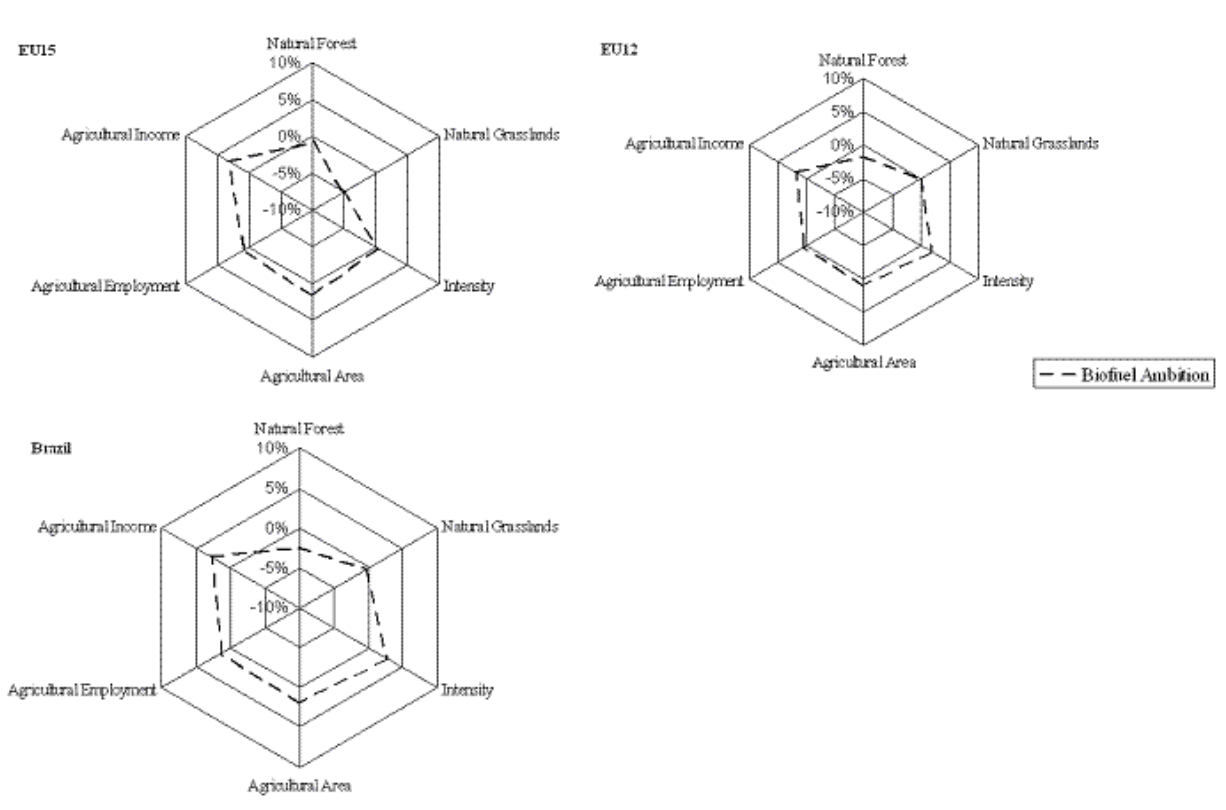
Fig. 7 . Trade-offs between environmental indicators, i.e., natural forest, natural grassland, and intensity of agricultural management, and socioeconomic indicators, i.e., agricultural income and agricultural employment in EU15, EU12, and Brazil in the Biofuel Ambition option compared to the